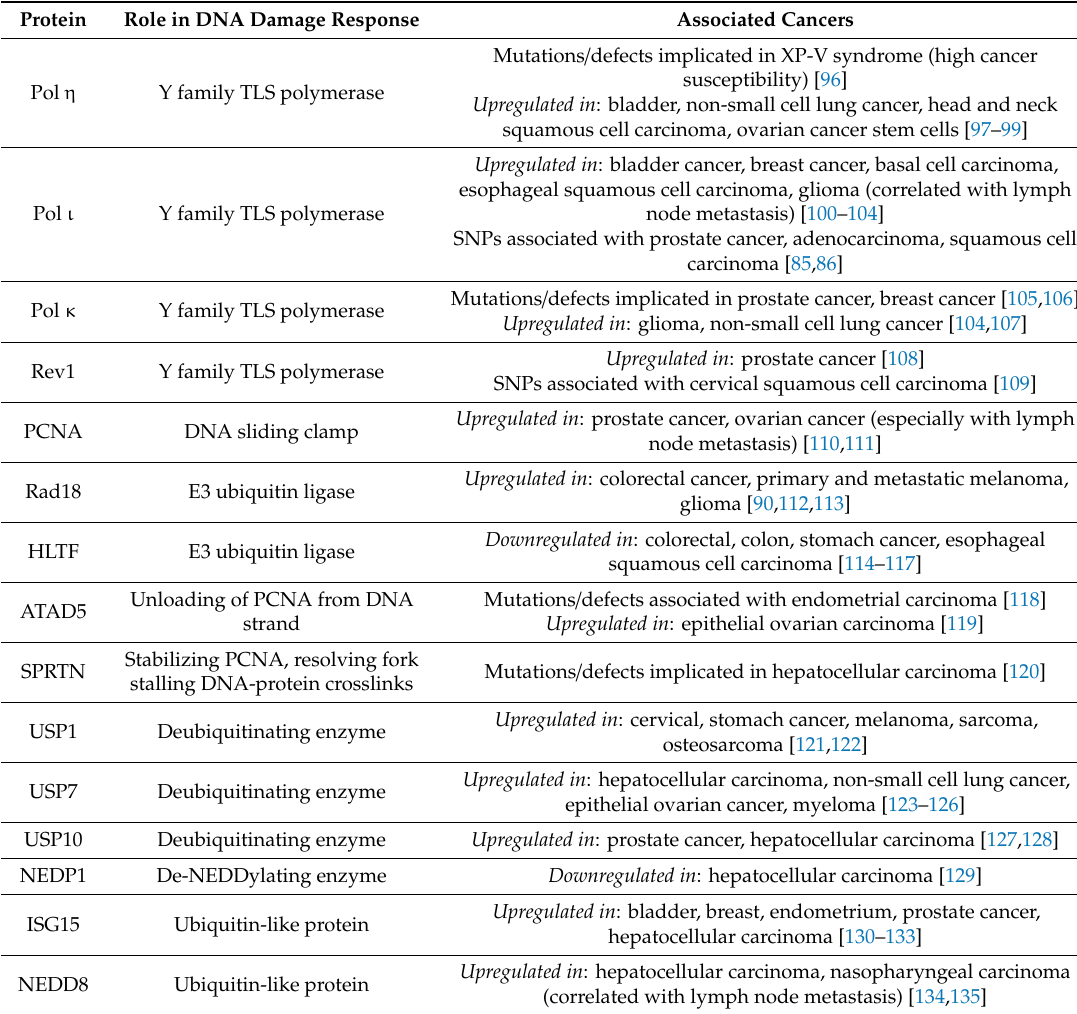
Table 1. Many proteins that bind to and metabolize ubiquitin and ubiquitin-like proteins in the DNA damage response are deregulated or mutated in